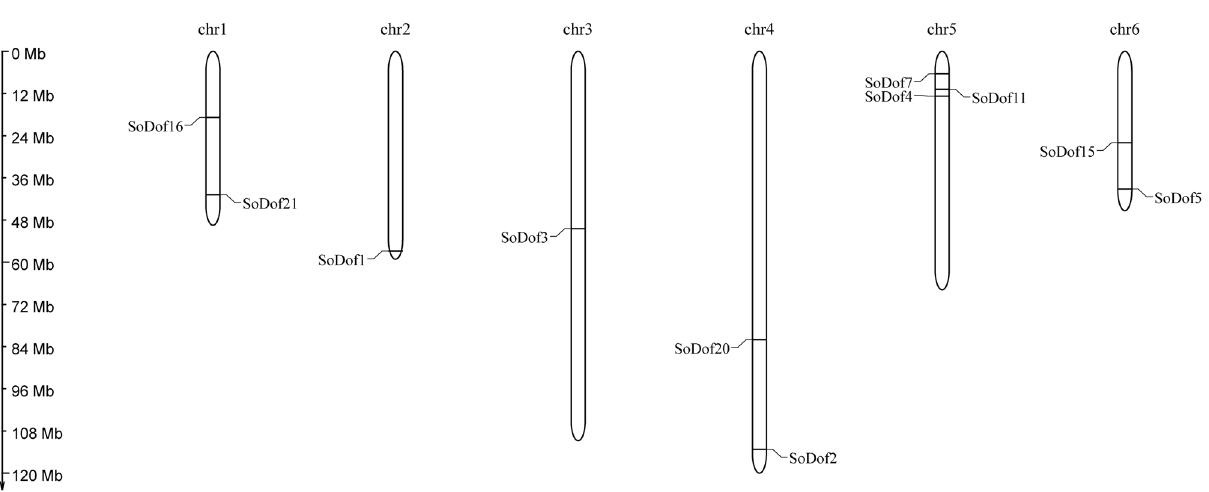
Figure 3. Chromsomal location of SoDof genes. The size of a chromosome is indicated by its relative length. Figure was made by MG2C (http:// mg2c. iask. in/ mg2c_